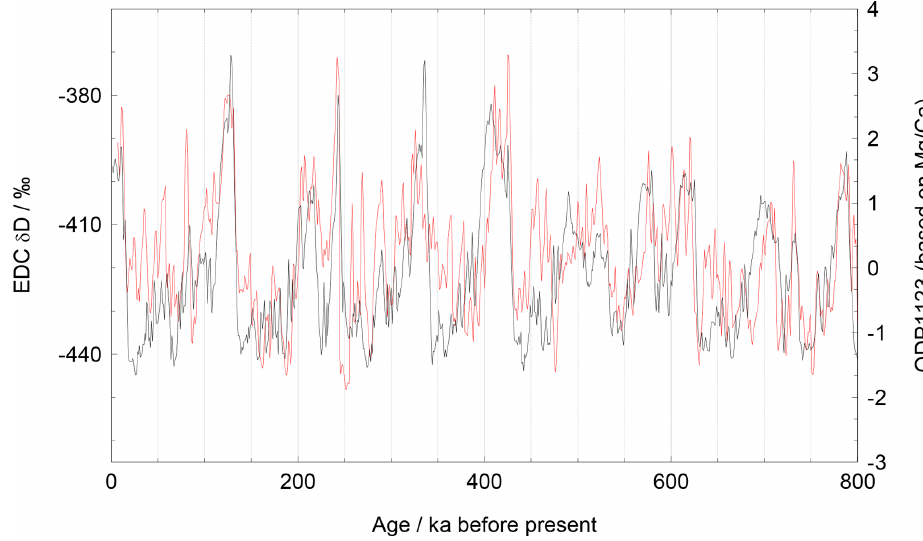
Figure 3. Ice core and marine sediment data reflecting temperature for the past 800kyr. EDC deuterium (black, AICC2012 age scale) (Jouzel et al., 2007). ODP site 1123 deepwater temperature (red, LR04 age model), based on Mg / Ca (Elderfield et al., 2012).